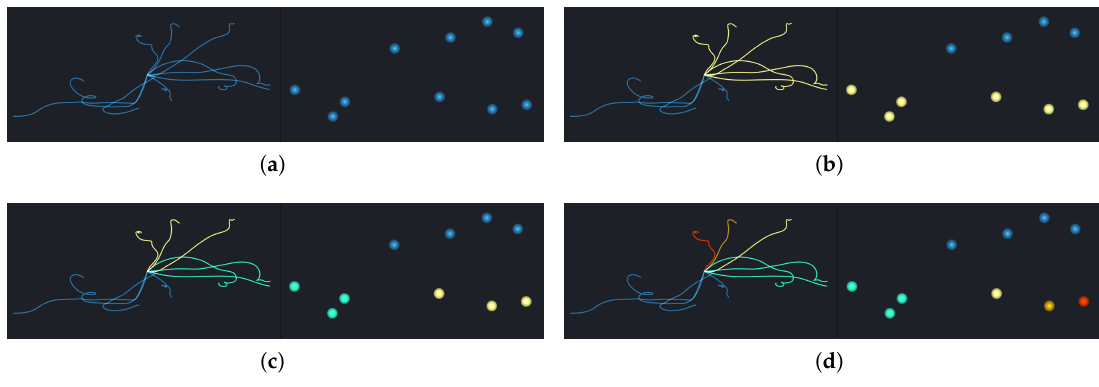
Figure 6. Clustering results with different parameters: ( a ) pathline view and projection view of pathline members before clustering; ( b ) pathline view and projection view of clustered pathline members with Eps = 0.8 and MinPts = 1; ( c ) pathline view and projection view of clustered pathline members with Eps = 0.75 and MinPts = 1; and ( d ) pathline view and projection view of clustered pathline members with Eps = 0.75 and MinPts =